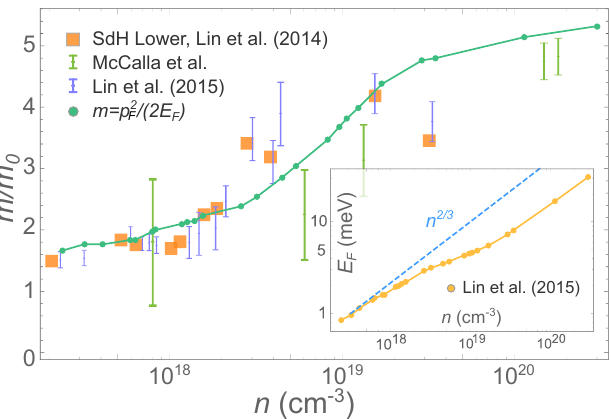
Figure 2: The effective mass m / m (vertical) vs electron density in log scale (hori- 0 zontal). Shown are the experimental values from Shubnikov-de Haas effect [ 19 ] (or- ange squares), from specific heat [ 24 ] (green dots), from quantum oscillations [ 26 ] (purple dots). The emerald green line showcases the m ( n ) dependence we used, which was obtained using a model of spherical Fermi surface via Eq. (11). The con- centration dependence of the Fermi energy is shown in the inset, see Ref. [ 26 ]